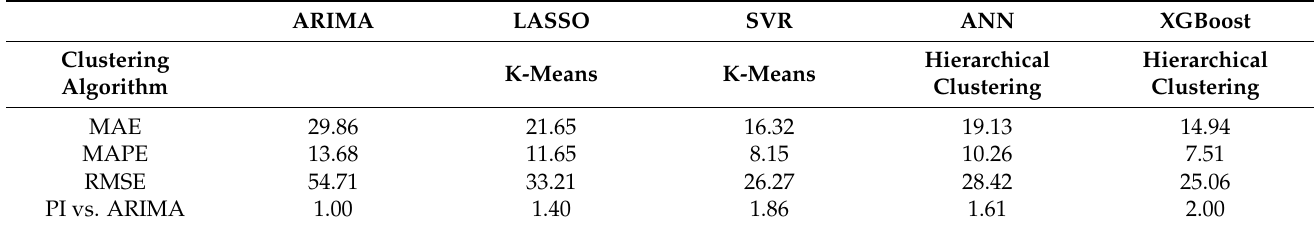
Table 5. Performance of the best ensemble models for different regression algorithms.